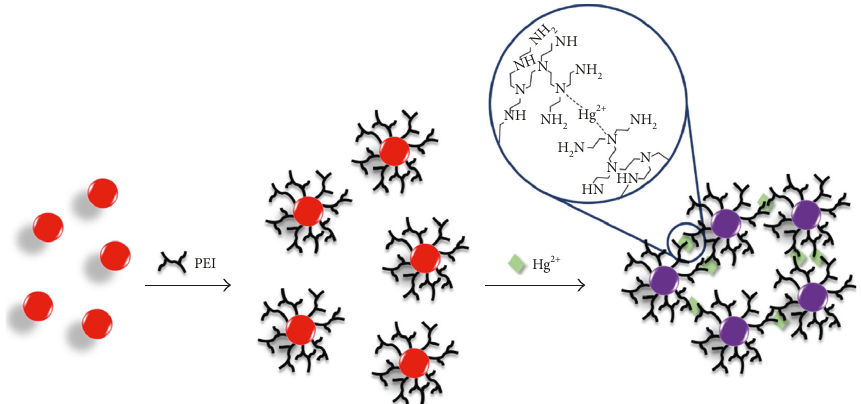
Scheme 1: Schematic illustration of the AuNPs capped with PEI, and the aggregation of PEI-AuNPs reacted with Hg 2+ ion, accompanied by a color change, and the predicted coordination bond between Hg 2+ ions and PEI-AuNPs.